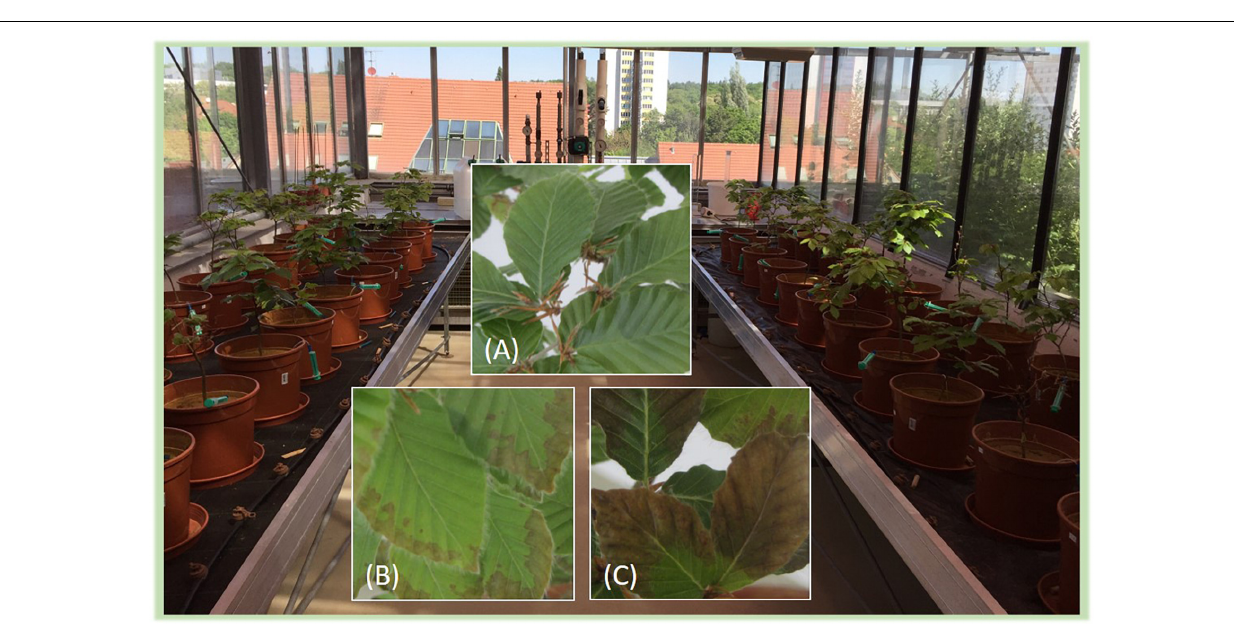
FIGURE 2 | Picture of the mesocosm experiment and of leaves (A) without symptoms, (B) with moderate symptoms, and (C) with severe symptoms supposedly caused by P deficiencies.